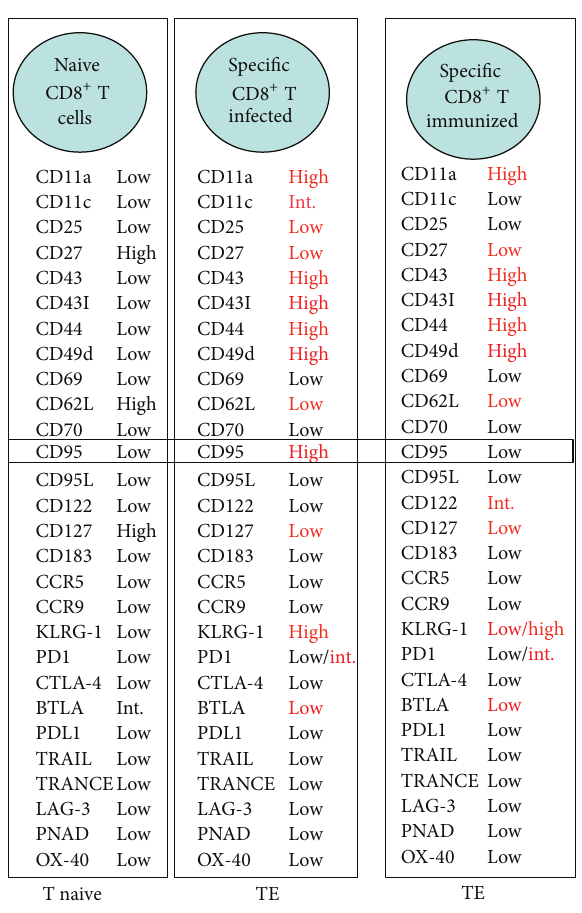
Figure 2: Surface molecules expressed by specific CD8 + T lympho- cytes following infection with T. cruzi and vaccination with AdASP-